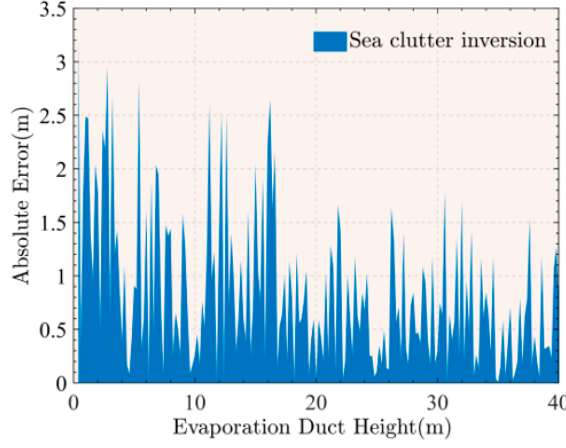
Figure 6. Absolute errors of sea clutter inversion.